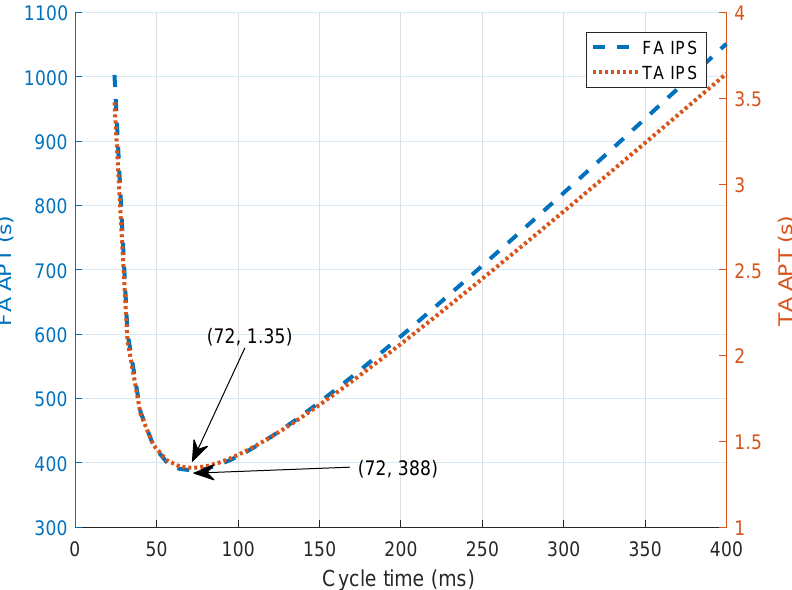
Figure 14. Reduction of APT in the overlap region through the use of receiver defined threshold angle (TA) instead of the conventional full angle (FA) for 12-bit packets in